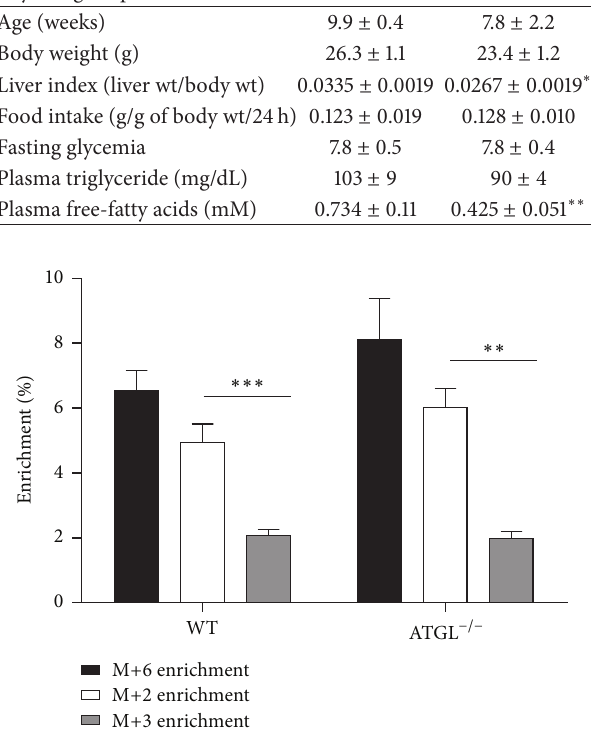
Figure 2: Percent enrichment of [U- 13 C 6 ]glucose (M+6), [1,2- 13 C 13 C 13 C 2 ] + [5,6- 2 ]glucose (M+2), and [1,2,3- 3 ] + [4,5,6- 13 C 𝑛 = 7 ) and ATGL −/− mice ( 𝑛 = 6 ). Data 3 ]glucose (M+3) in WT ( are expressed as mean ± SEM. ∗ 𝑃 < 0.05 .